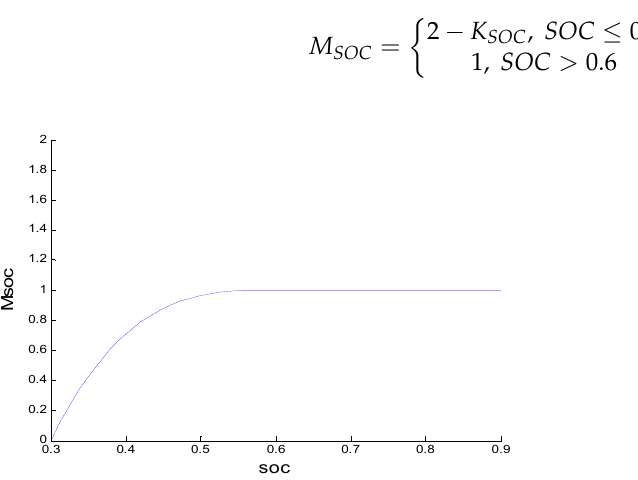
Figure 17. Compensation coefficient 𝑴 𝑺𝑶𝑪 with power battery SOC curve